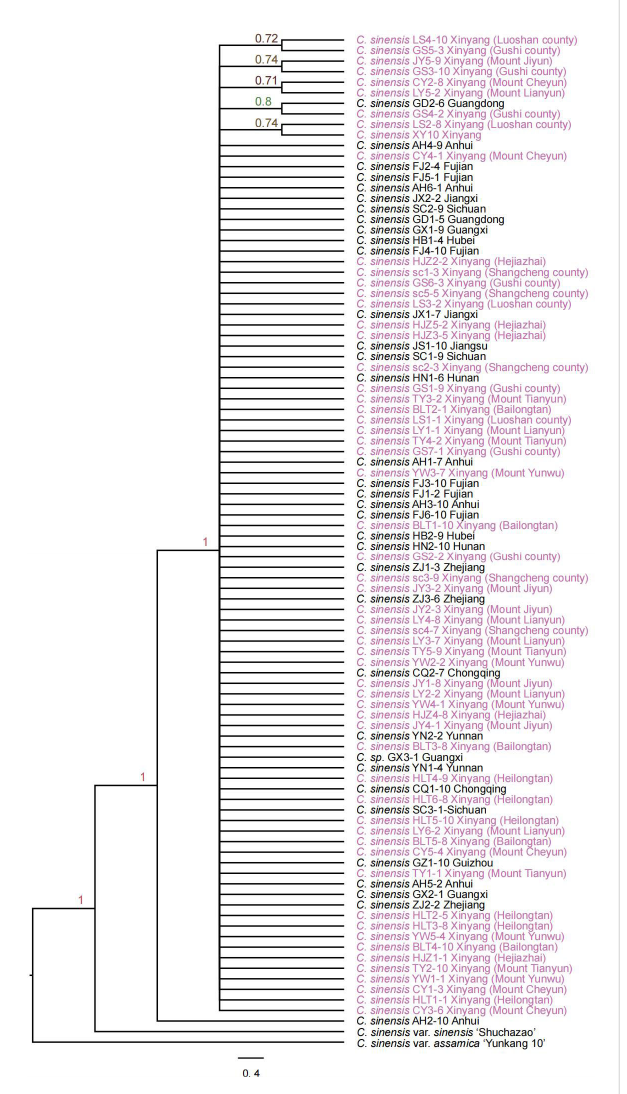
FIGURE 3 The coalescent phylogenetic tree was inferred from 94 Camellia samples with 1785 low-copy nuclear genes. The nodes with posteriori probability (PP) less than 0.7 were collapsed into a comb. The species names with purple color indicate samples collected from Xinyang City.